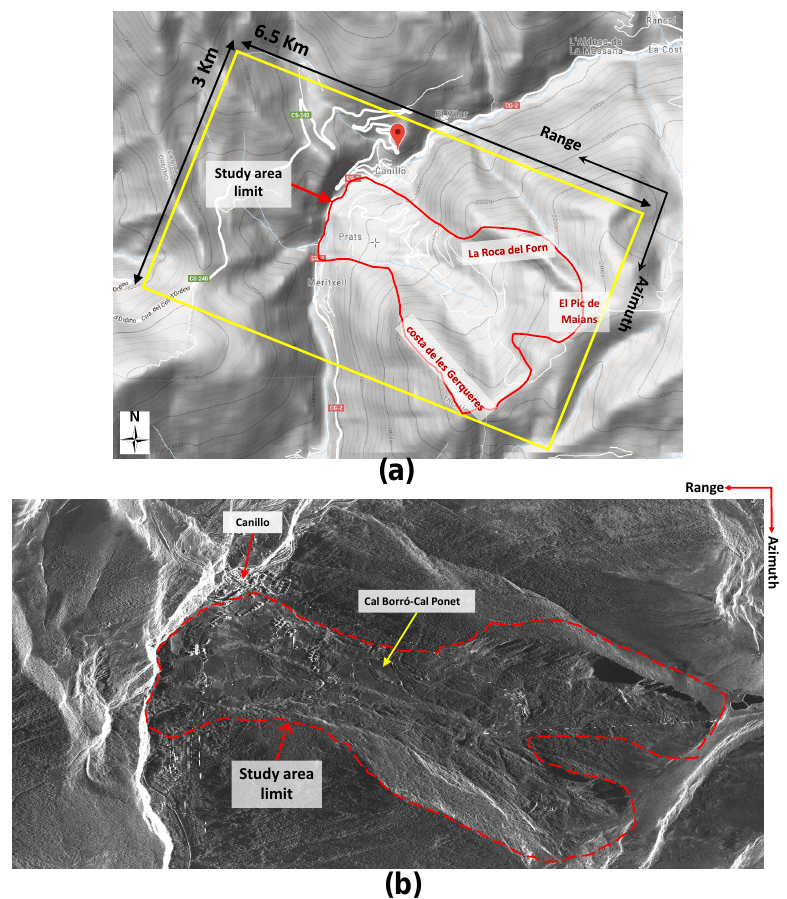
Figure 2. ( a ) coverage of the TerraSAR-X dataset (i.e., the yellow rectangle) displayed on a topographic map of the area (map from https://elevationmap.net); ( b ) amplitude of an SAR image in radar coordinates (azimuth, slant-range) acquired by the TerraSAR-X sensor in Staring Spotlight mode, and the red line illustrates the boundary of the study area limit. Table 1. Main parameters of the employed Staring Spotlight TerraSAR-X images. Heading and LOS angles defined clockwise with respect to the